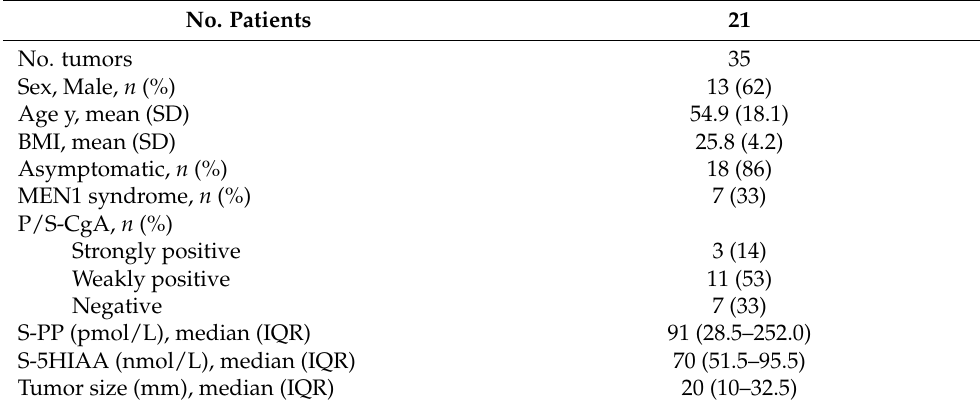
Table 2). Patients were treated in accordance with European Guidelines [16]. Table 1. Patient